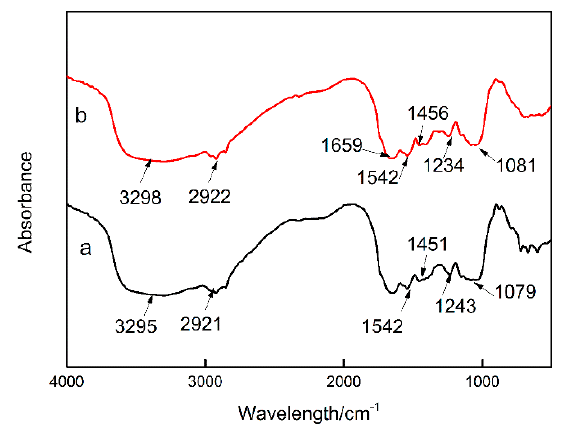
Figure 5. FTIR spectra of Synechococcus PCC7002 ( a ) and Cs-loaded Synechococcus PCC7002 ( b ).